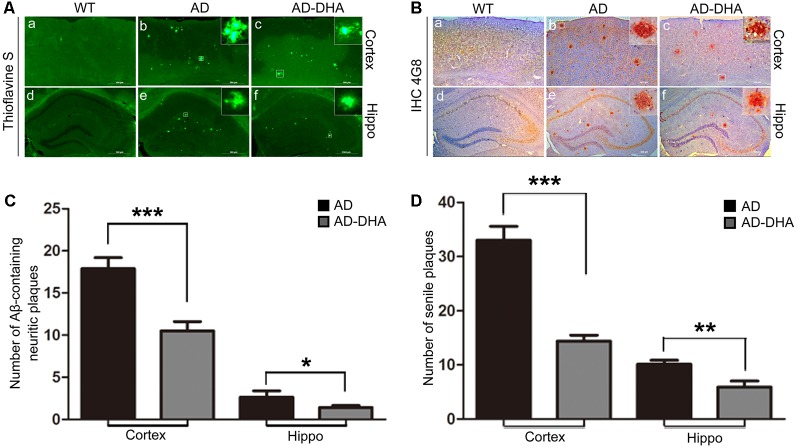
Effects of DHA on Aβ aggregation and senile plaque (SP) deposition. The brains were prepared from mice treated with intragastric administration of DHA (20 mg/kg/day) or DMSO for 90 days. Thioflavin S staining (Aa–f) and immunohistochemistry (Ba–f) showed Aβ-containing neuritic plaques and SP in the cortex and hippocampus of WT mice, DMSO-treated AD mice, and DHA-treated AD mice. The number of Aβ aggregates (C) and the number of SP as determined by immunohistochemistry (D) in the cortex and hippocampus are illustrated as histograms. n = 6. *p < 0.05, **p < 0.01, and ***p < 0.001 compared to the DMSO-treated AD group. Student’s unpaired t-test was performed for histological staining data and ELISA results. Scale bar = 500 μm.